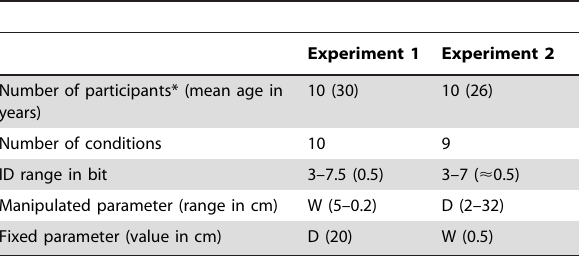
Table 1. Participants and experimental conditions details for each